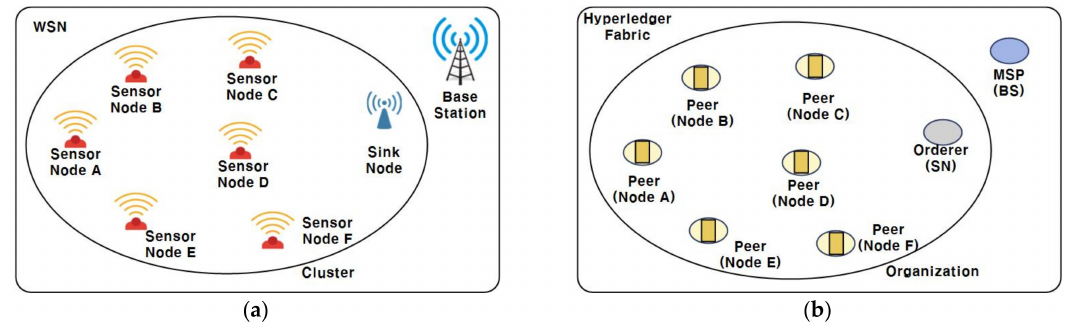
Figure 6. A WSN employed with our proposed model. ( a ) general WSN viewpoint; ( b ) blockchain (HyperLedger Fabric) network